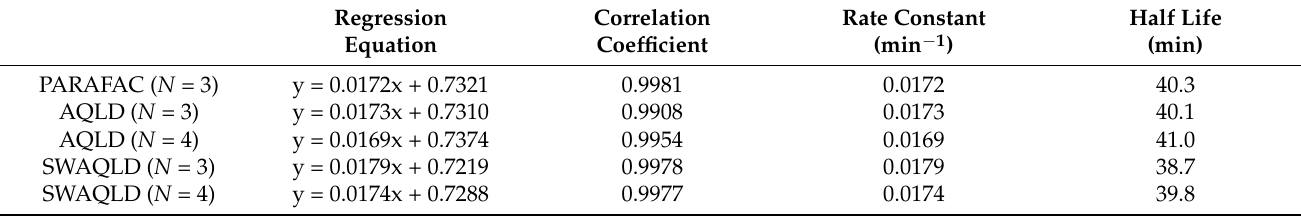
tion; Figure S2: The results of 8 components for the first real four-way phosphorescence data using different methods, (a) CORCONDIA and (b) AWQLD-MCS; Figure S3: The results of 8 components (b) AWQLD-MCS; Table S1: The convergence property of PARAFAC, AQLD and SWAQLD for